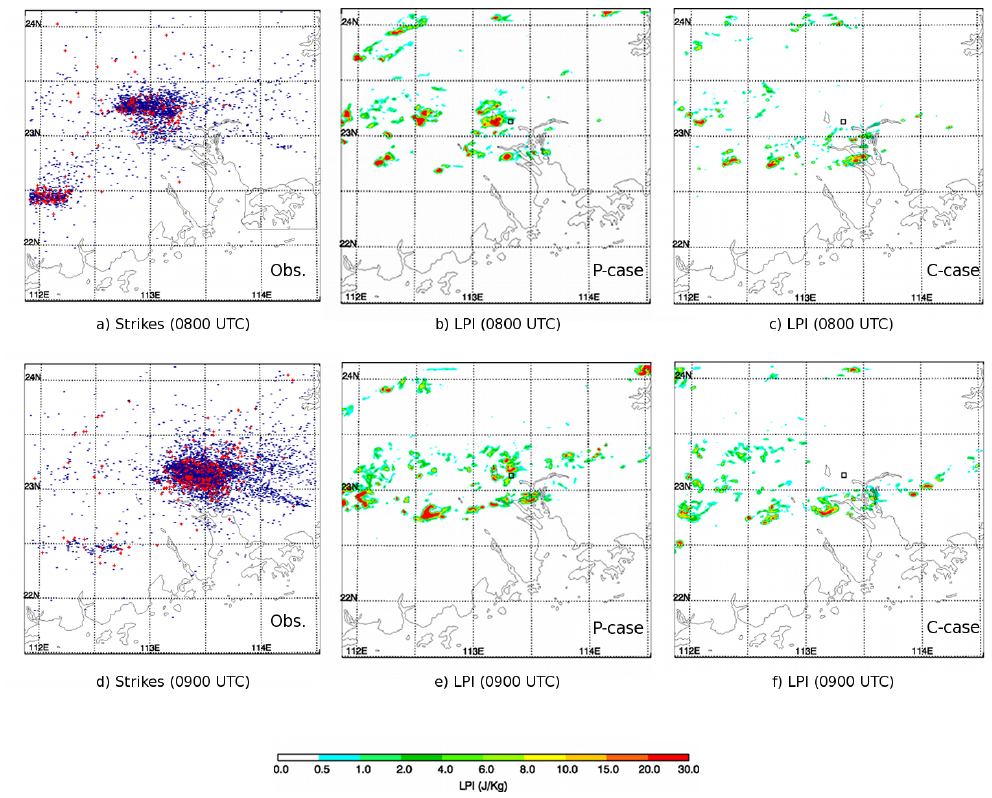
Fig. 12. (a) Observed CG lightning distribution at 08:00UTC. (b) Simulated LPI in the P-case at 08:00UTC. (c) Simulated LPI in the C-case Figure 12. at 08:00UTC. (d) Observed CG lightning distribution at 09:00UTC. (e) Simulated LPI in the P-case at 09:00UTC. (f) Simulated LPI in the C-case at 09:00UTC.